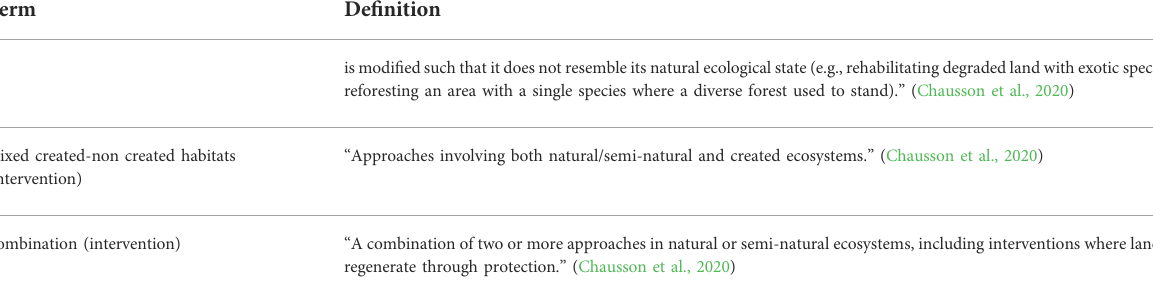
TABLE 1 ( Continued ) De fi nitions of key social-ecological terms and intervention